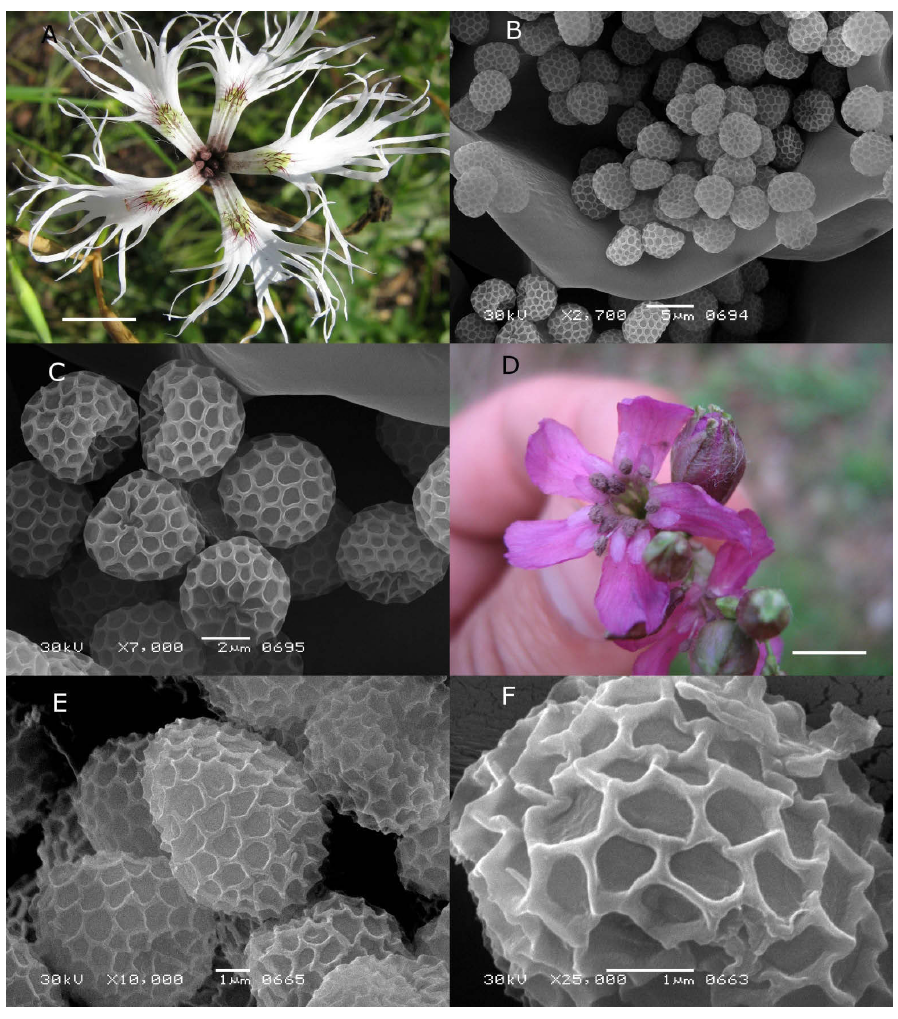
Fig. 2. Microbotryum superbum on Dianthus stenocalyx : A – infected flower, B, C – spores. Microbotryum lagerhemii Denchev on Lychnis viscaria : D – infected flowers, E, F – spores; B, C, E, F – in SEM. Scale bars for A, D = 5 mm; B = 5 μm; C = 2 μm; E, F = 1